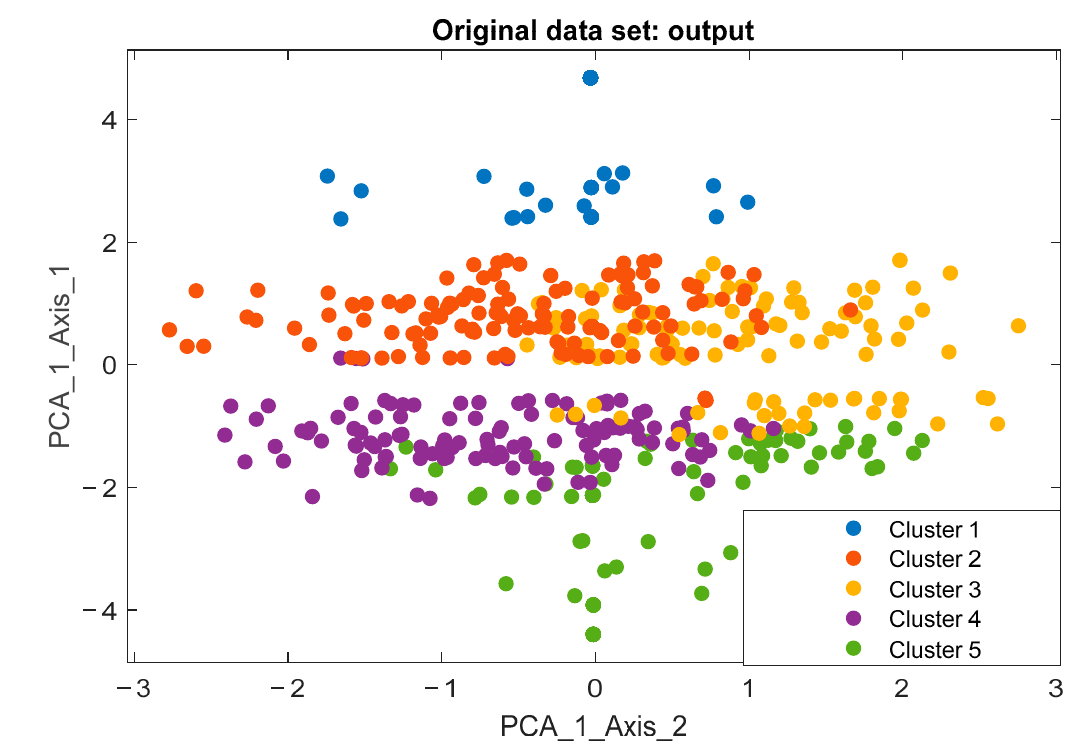
Figure 3. Visualization of SOM clusters via PCA.